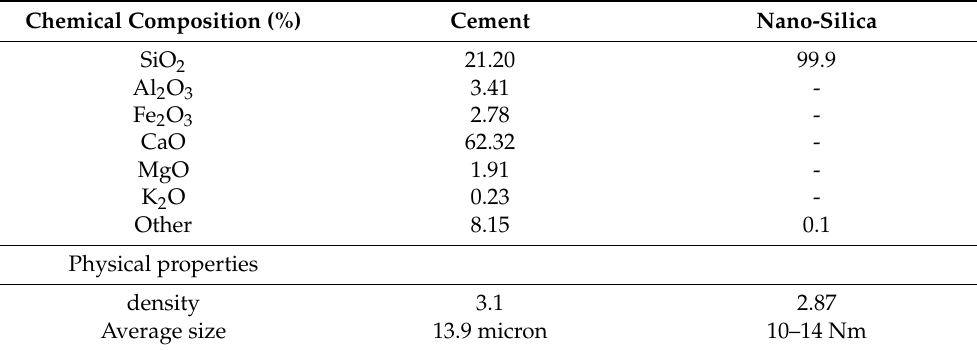
Figure 3. The scanning electron microscope (SEM) image of Nano-silica (provided by Iranian Nanomaterials Pioneers Company). Table 1. Chemical and physical composition of cement and nano-silica.